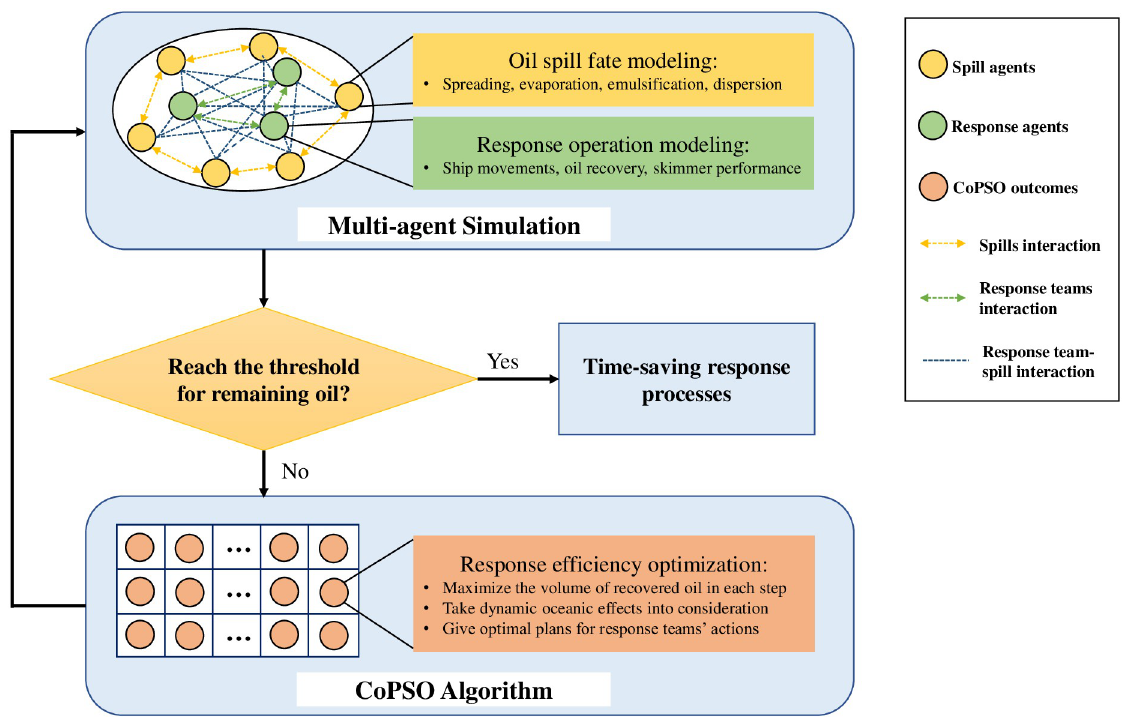
Fig 6. Implementation of the MAS-CoPSO approach in the case